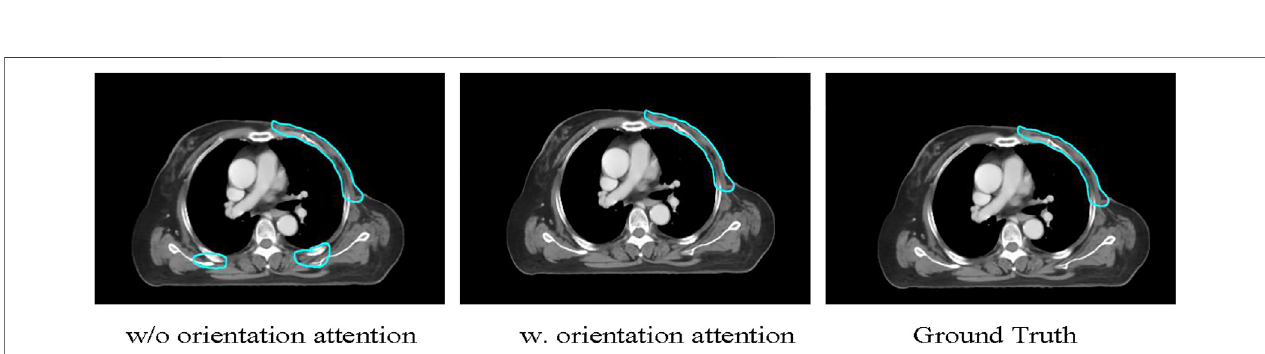
FIGURE 6 | The illustration of the usefulness of the proposed method in recognizing the breast side correctly. The U-Net model incorrectly segments dorsally structurally similar regions as target CTVs, while the proposed method successfully identi fi es the breast side and segments the target CTVs.